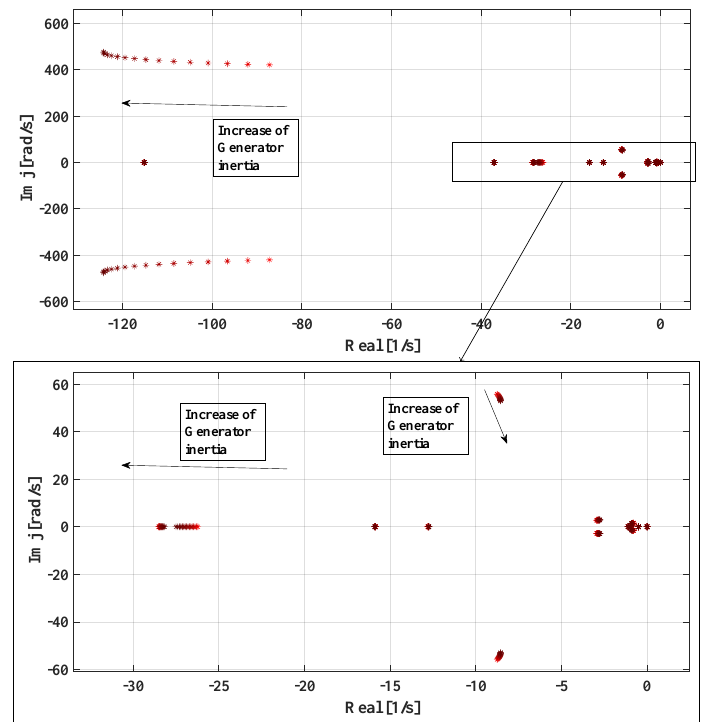
Figure 8. Eigenvalues with varying generator inertia